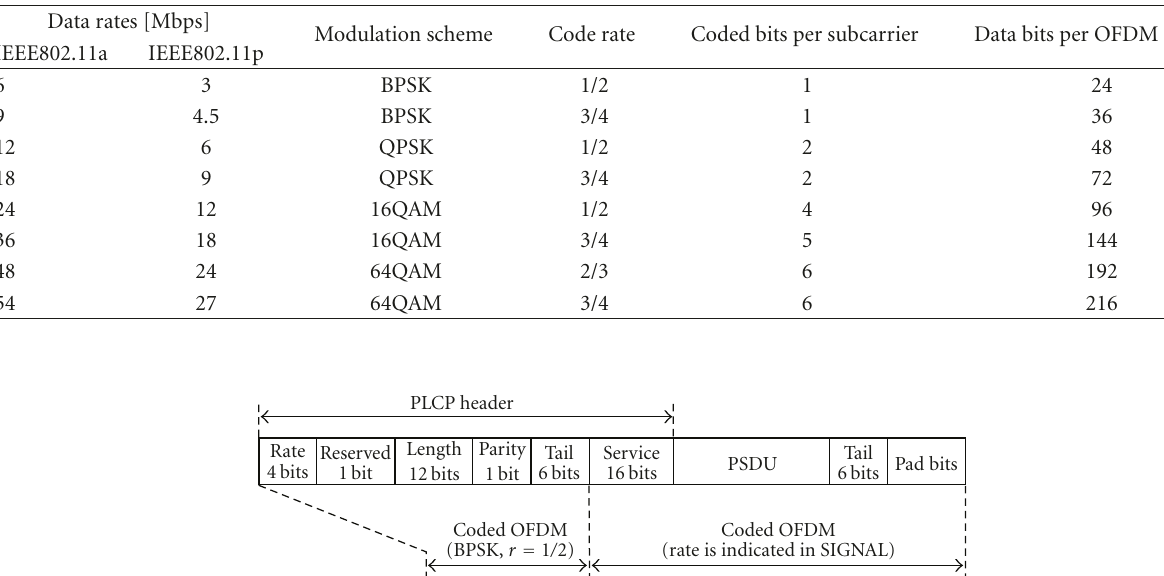
Table 1: System parameters according to data rate.